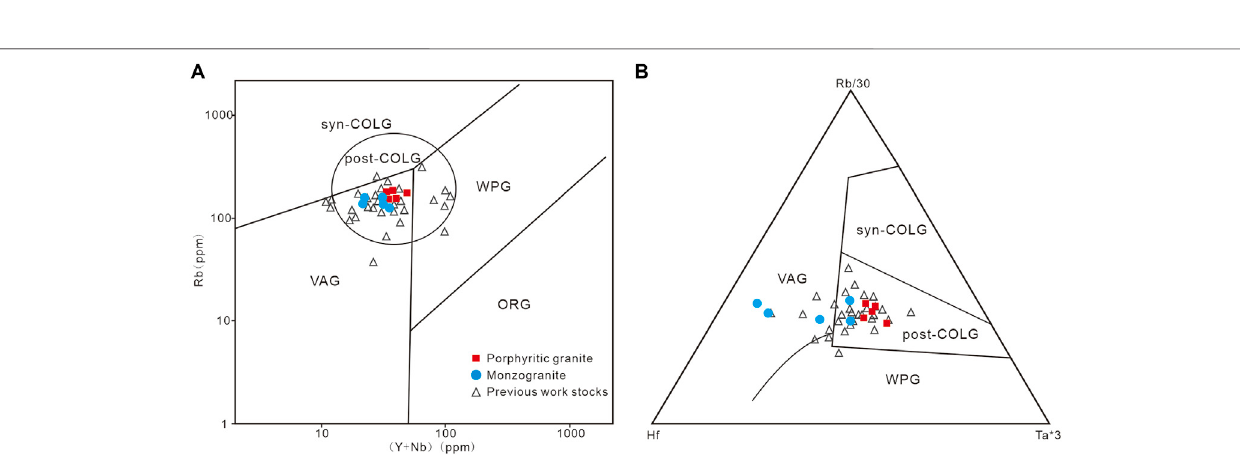
FIGURE 9 | Rb-(Y + Nb) plot [ (A) after Pearce, 1996] and Hf-Rb/30-Ta*3 plot [ (B) after Harris et al., 1986] of Yaozhuang stock.